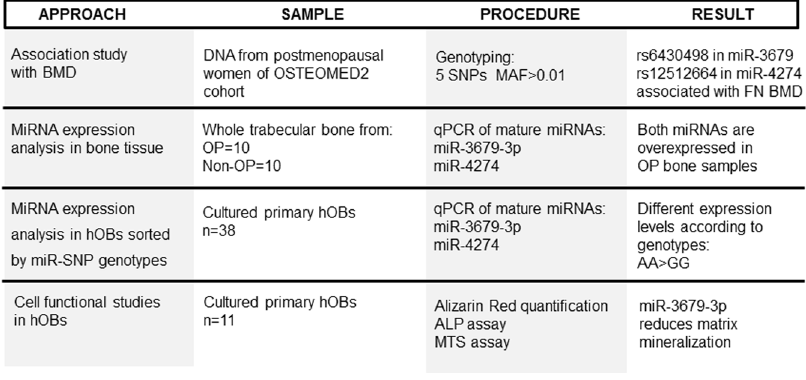
Figure 1. Schematic overview of the whole procedures, samples and results of the